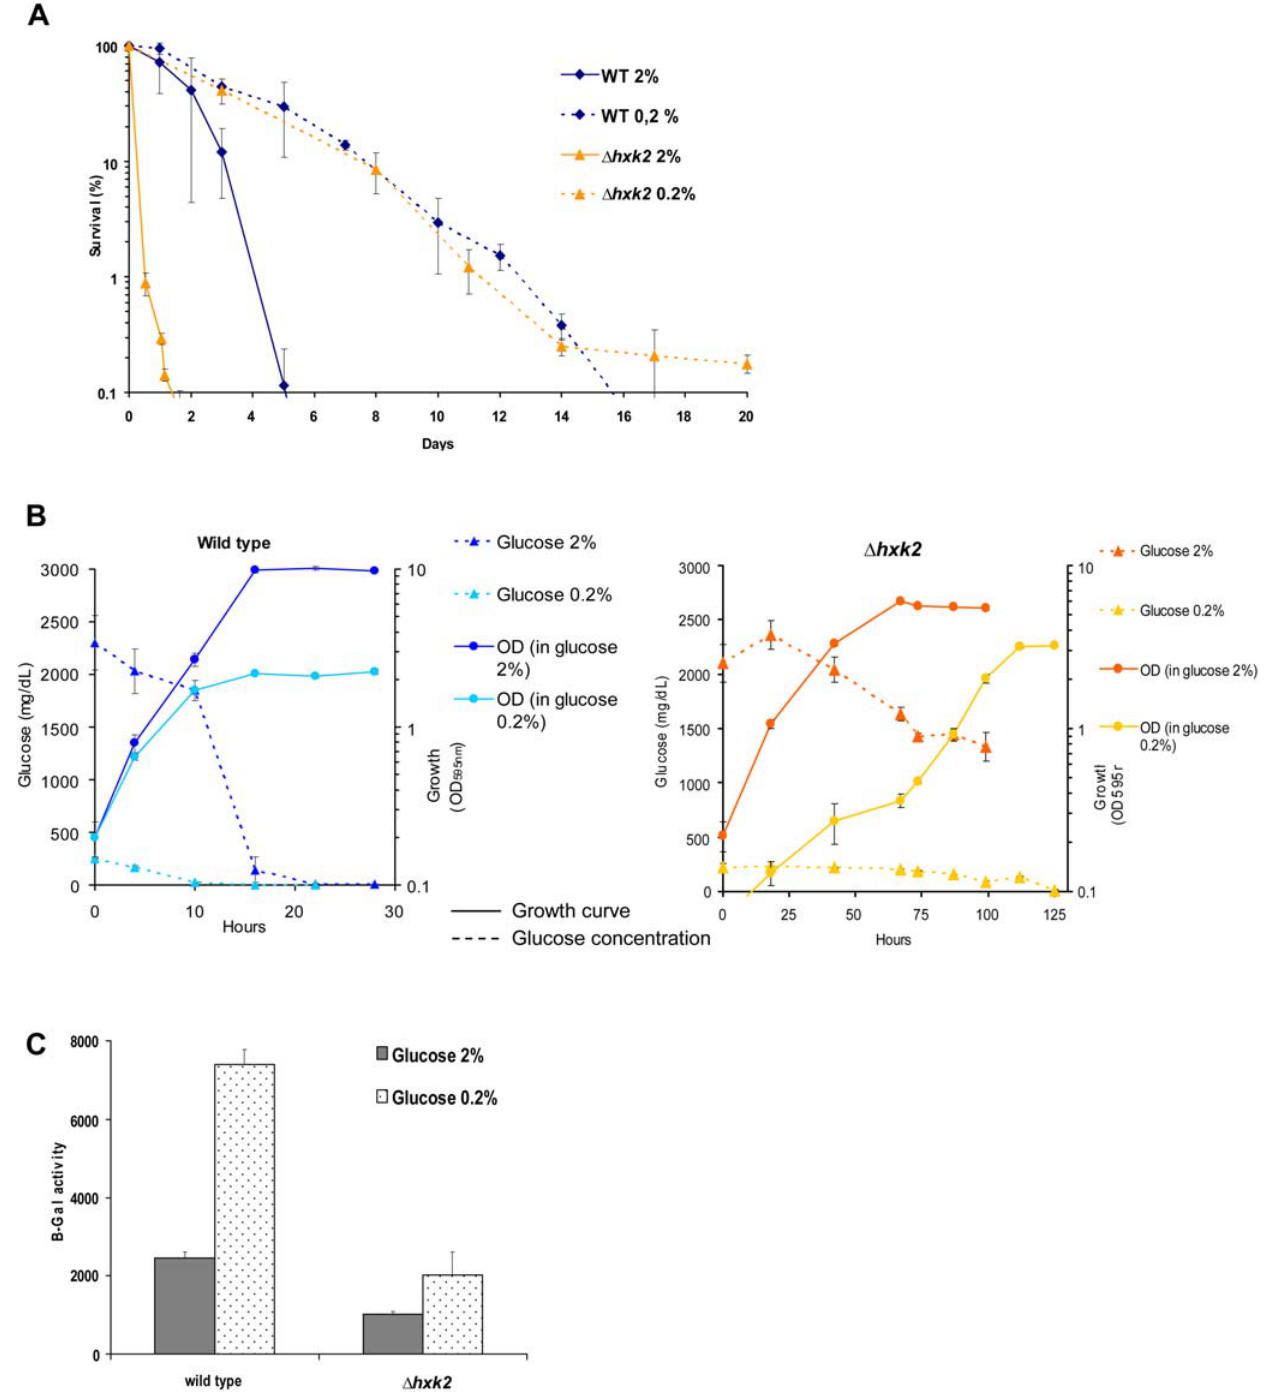
Figure 5. Hexokinase 2 mutant has a decreased survival and an increased glucose signaling in stationary phase. Impairing glucose metabolism strongly decreases CLS and increases Git3/PKA signaling in late exponential phase cells. This pro-aging effect is lost when less glucose is provided. (A) CLS of WT and D hxk2 in low and high glucose concentration. (B) Glucose consumption according to growth in WT and D hxk2 cultured in 2% and 0.2% glucose. (C) b -Galactosidase activity of D hxk2 with fbp1-lacZ reporter. Cells were collected at late exponential phase and b - galactosidase activity was measured.